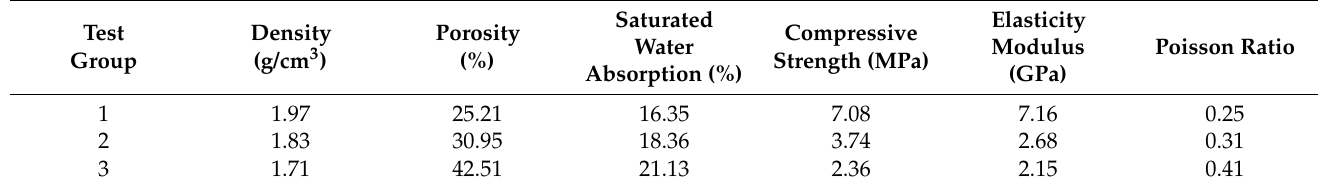
Table 2. Measurement results of physical and mechanical properties of CRC similarity model.